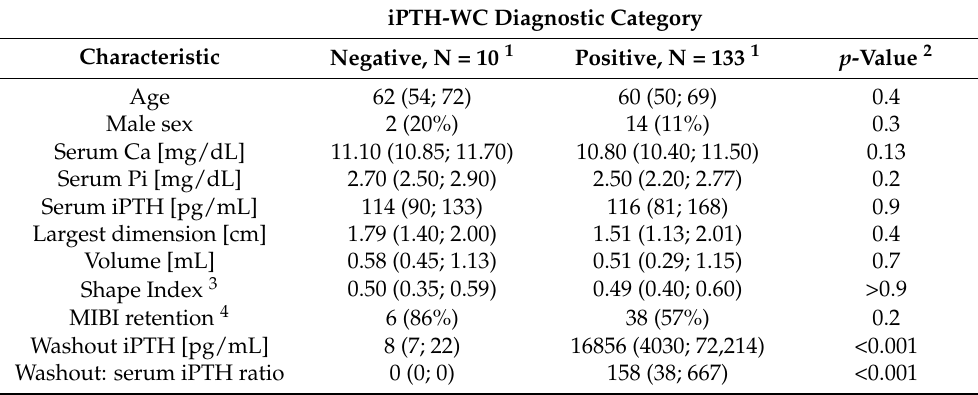
Table 2. Comparison of positive and negative results of iPTH-WC measurement. iPTH-WC Diagnostic